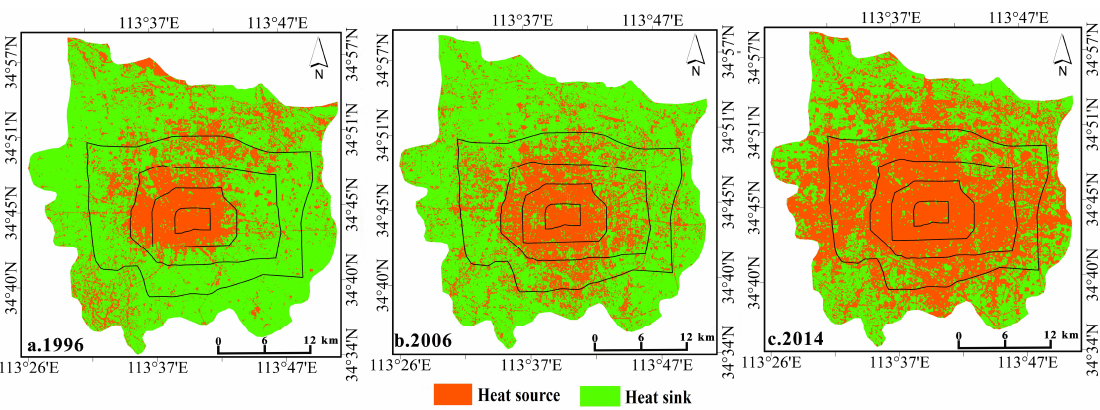
Figure 6. Spatial distribution of heat sources and sinks in Zhengzhou City in ( a ) 1996, ( b ) 2006, and ( c )